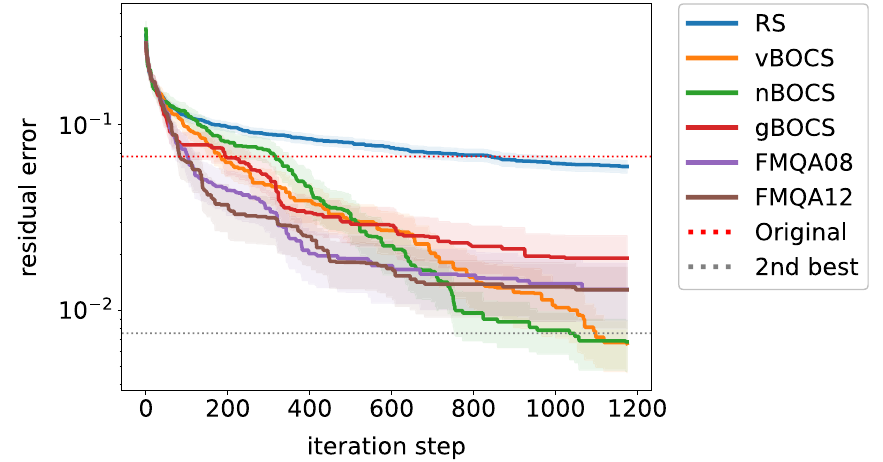
Figure 1. The residual error of lossy compression of a matrix (instance) as a function of iteration step among various algorithms with 95% confidence intervals. The red- and grey-dotted lines indicate the residual error of the original algorithm and the second-best solution by brute-force